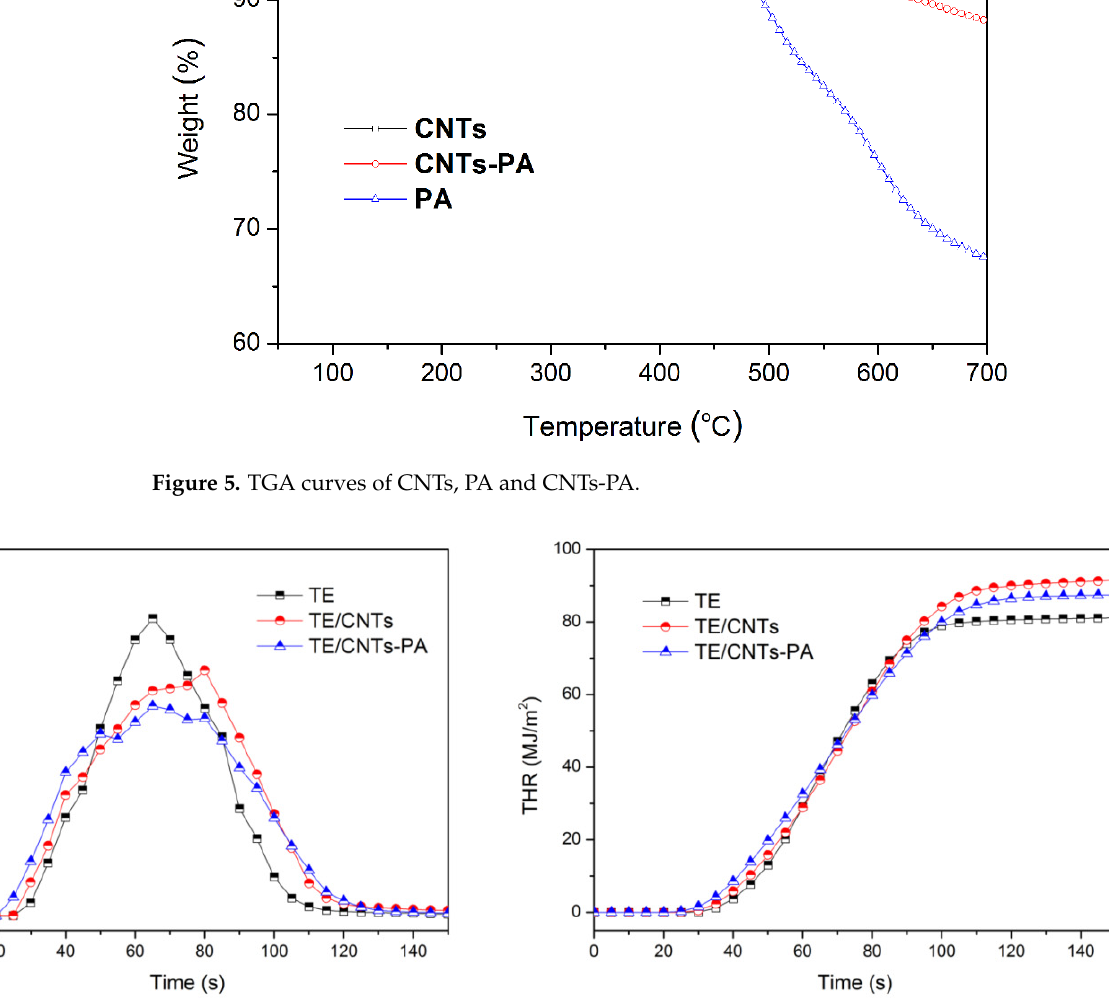
Figure 7 . SEM images of TE ( a ) and TE/CNTs ‐ PA ( b ) nanocomposites. The dynamic storage modulus (E’) and the loss tangent (tan δ ) versus the tempera ‐ ture of TE nanocomposites was presented in Figure 8. It can be seen that the incorporation of CNTs decreases the E’ of the nanocomposites slightly (Figure 8a). However, after func ‐